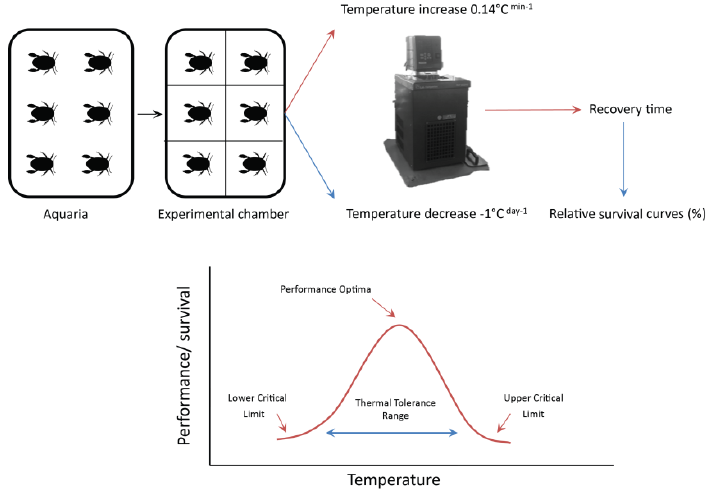
Figure 2. Conceptual scheme of the critical thermal limits determination in the present study.